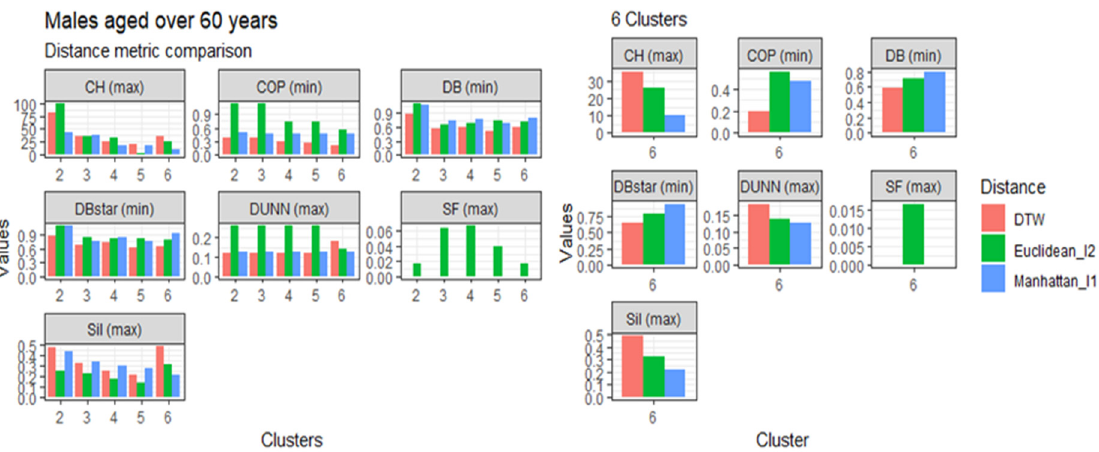
Figure 5. Model comparison of the DTW, Euclidean (l1), and Manhattan (l2) distance criteria for males aged 20 to 60.